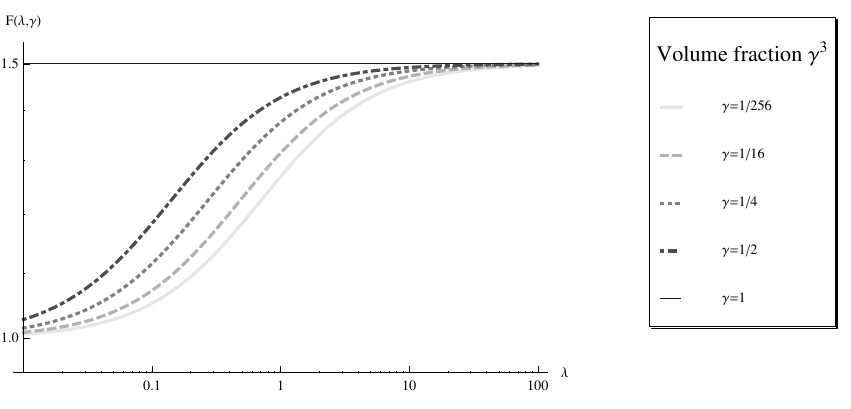
Figure 5. Loglog plot of the dimensionless drag force F ( λ , γ ) as a function of the viscosity ratio λ with fixed values of the volume fraction, γ 3